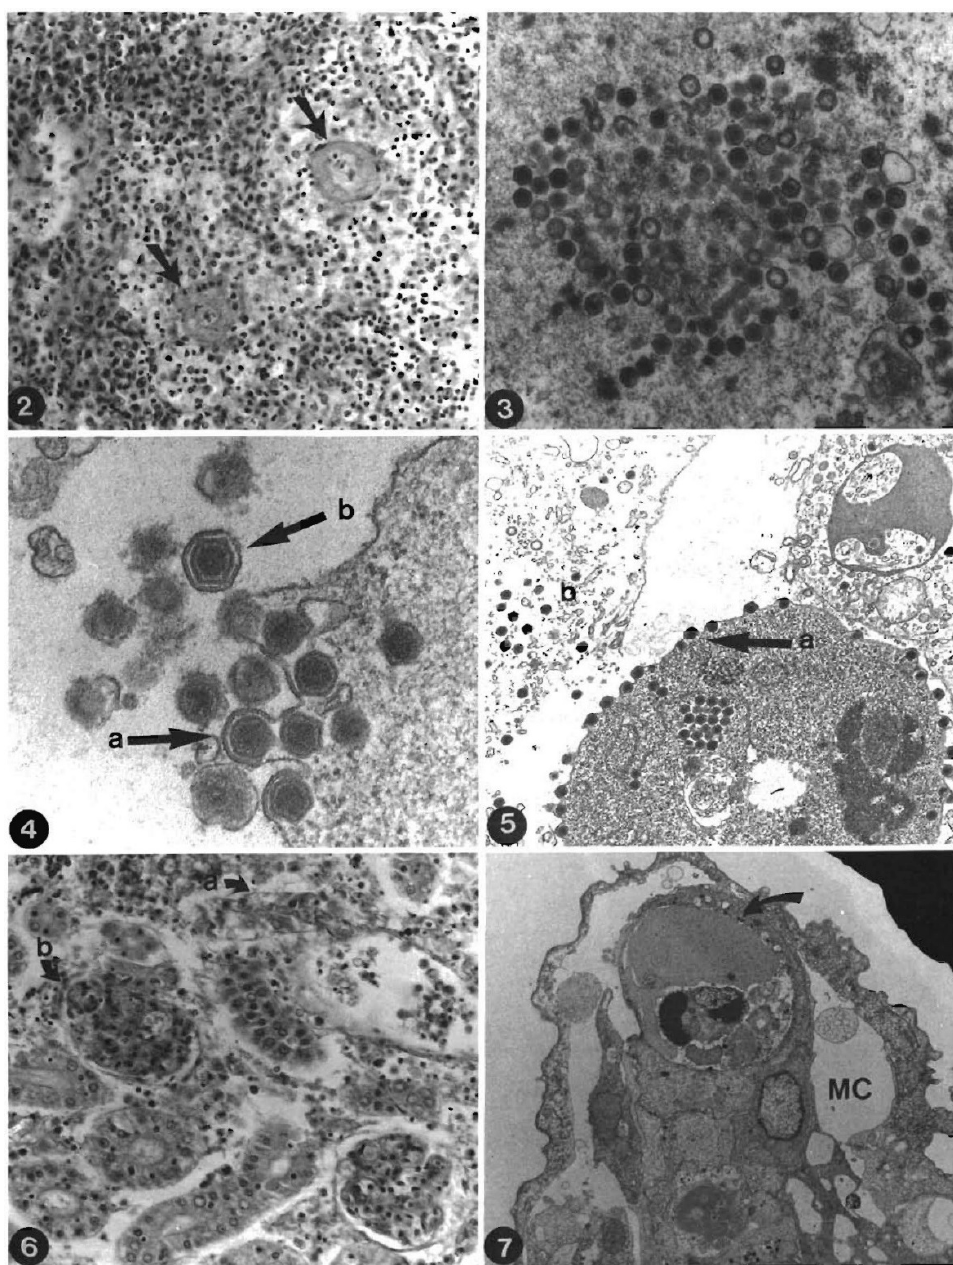
Figure 2. Silurus glanis pathological alterations. 2 (cid:13) ([17]) Spleen. Degeneration of vascular walls (arrows) and parenchymal haematopoietic necrosis H and E. × 300. 3 (cid:13) ([17]) Spleen. Complete and incomplete virus particles within the cytoplasm. TEM, × 27,400. 4 (cid:13) ([17]) Spleen. Viral particles receiving envelope by budding from the plasma membrane. a Budding process. b released virion TEM, × 51,200. 5 (cid:13) ([17]) Kidney. a: Release of enveloped viruses from the cell; b lytic area with non-enveloped virus particles. TEM. × 14,700. 6 (cid:13) ([17]) Kidney. Renal excretory system. Degeneration of (a) renal tubules; (b) renal corpuscle H and E. × 300. 7 (cid:13) ([17]) Gills, secondary lamella. Virus particles (arrow) endothelium of marginal channel (MC) Oe-dema of respiratory epithelium with separation from basement membrane TEM, × 4900 (Ogawa et al., 1990; with permission; “©Inter-Research 1990”). The molecular characterisation and phylogenetic classification of ESV (and ECV) have been based on REA and sequencing of partial gene regions for about 30 years. Ma- vian et al. [31] reported the first whole genome of the European Sheatfish Virus. It